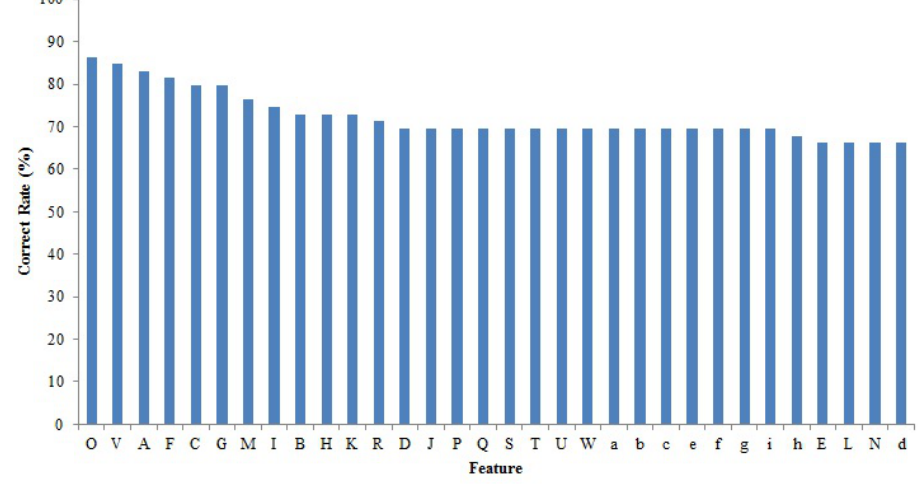
Figure 7. Single feature performance of J48